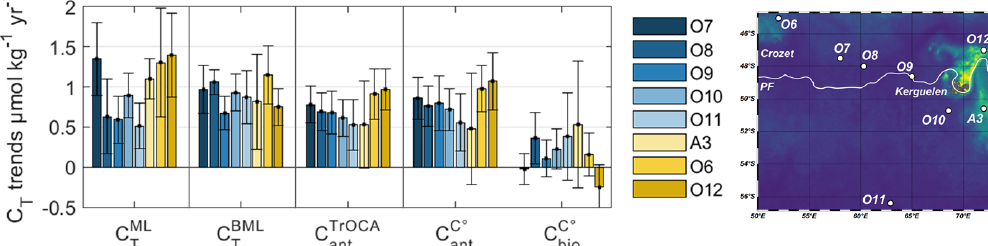
Figure 5. C T trends in the summer mixed layer (ML) and below the summer mixed layer (BML). Decomposition of C BML and C 0 methods) and C bio from C 0 method. The three phytoplanktonic bloom stations are reported in yellow (last three) and are separated from the HNLC stations (first five, shown in blue). To help the interpretation, a map with the localisation of these station is included (same map as Fig. 1).